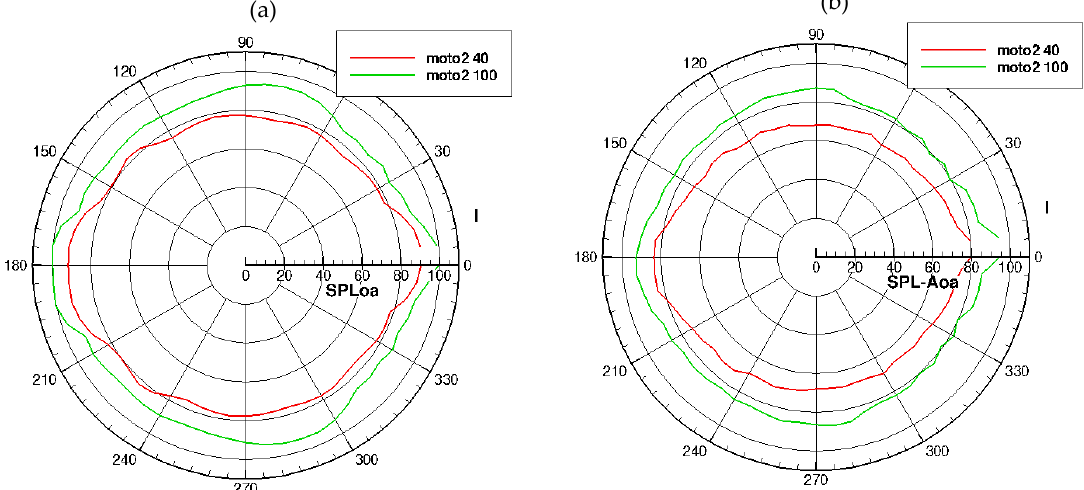
40% and 100% Figure 23. Motorization 2, OASPL values on the horizontal XY plane ( a ), A-weighted values on ( b ). Comparison between 40% and 100% ETR.